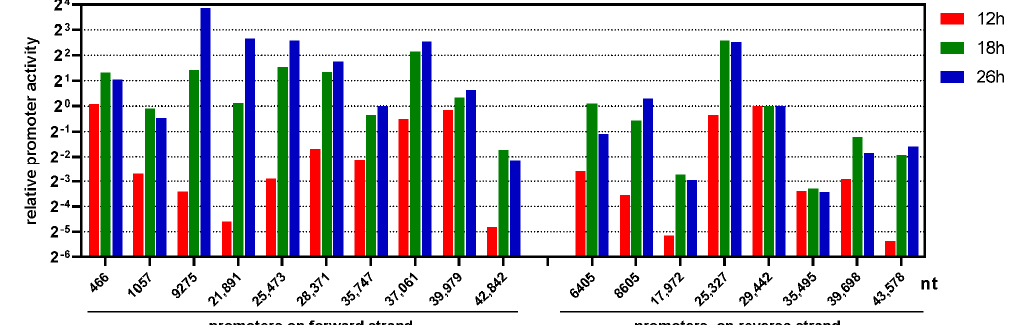
Figure 12. Relative transcriptional activity of promoters. At every time point, the full-length reads, which started within a distance of 30-nt to a major transcription start site (TSS), were counted up and treated as the total mRNAs of the TSS. The total full-length reads at that time point (including those from cells and from viruses, Table S1) were divided by 1,000,000 and used to normalize the copy number of viral mRNAs. The answers were the normalized reads count, which represented the promoter activity at a TSS. It could be seen that the normalized reads count at 29,442-nt on the reverse strand were 1456, 1502 and 1519 at 12, 18 and 26 h post-infection, respectively, which were relatively stable. The normalized reads count at all major TSS was divided by that at reverse 29,442- nt at various time points, and the answers were relative promoter activity. 4. Discussion 4.1. Nanopore Full-Length cDNA Sequencing was a Reliable Solution for Revealing FAdV-4 Transcritpome when Being Combined with the Accurate Short-Read Sequencing Technology Oxford nanopore long read RNA sequencing can be carried out with three protocols, including PCR-cDNA, direct cDNA and direct RNA [23], and we chose the procedure of PCR-cDNA in this study. The first step of PCR-cDNA is to convert mRNAs to full-length cDNAs with an oligo(dT)-containing primer to start the reverse transcription and ensure an intact 3 ′ -end of the transcript. After the reverse transcription extends to the 5 ′ -end of the mRNA, several cytidines are added to the terminal of the cDNA in a template-inde- pendent manner thanks to the property of the used reverse transcriptase. Strand-switch- ing primer (SSP), which contains several guanosines at the 3 ′ -end, will bind to these cyti- dines and serve as the succeeding template, and the reverse transcription will continue until the reverse complementary sequence of SSP is incorporated into the cDNA. The tem- plate-switching step ensures a complete 5 ′ -end of the mRNA to be included in the cDNA. This template-switching reverse transcription technique is widely used in full-length cDNA cloning (rapid amplification of cDNA ends, RACE) and has been used for more than two decades, indicating its reliability [51–53]. In contrast, an inability to read ~15 nucleotides at the 5 ′ end of each strand and relatively higher error rates were identified as the two principal drawbacks of direct RNA sequencing [24,54]. The PCR step during li- brary building can help increase sequence depth [10], although the quantification accu- racy of some transcripts will be compromised because not all genes are equally amplified [55]. The nucleotide errors in nanopore PCR-cDNA data were corrected with parallel Il- lumina short-read RNA sequencing before FAdV-4 transcriptome parsing. The distribution patterns also suggested a plausible detection of the major TSS and TTS in the FAdV-4 genome. Theoretically, random degradation or physical truncation at the terminals of mRNAs should generate a symmetrical Gaussian distribution for the po- sition of the 5 ′ - or 3 ′ - ends of a transcript. Conversely, the results of PCR-cDNA sequencing showed an abrupt increase in copy number at a certain position for the 5 ′ -end of tran- scripts and an abrupt decrease in copy number beyond a certain nucleotide at the 3 ′ -end (Figure 1), suggesting the detection of real TSS and TTS from full-length cDNAs but not terminals of degraded or truncated transcripts. Based on the distribution shape of